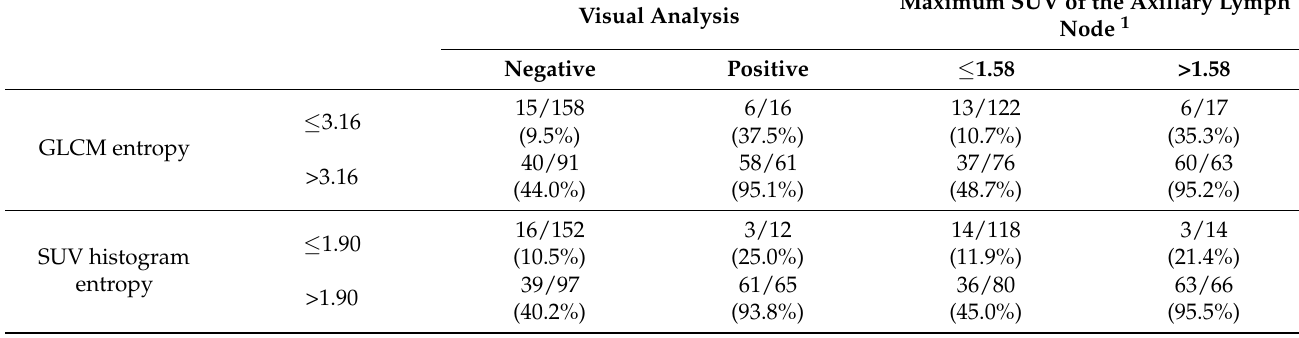
Table 3. Rates of the patients with axillary lymph node metastasis based on the combination of axillary lymph node findings on PET/CT (visual analysis and maximum SUV) with GLCM entropy and SUV histogram entropy of peritumoral breast adipose